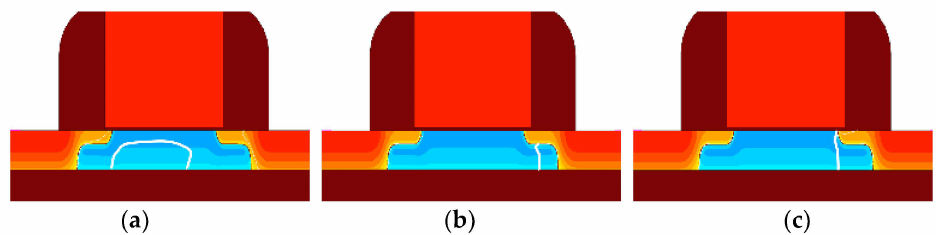
Figure 4. Length change of the depletion region (white curve) of the PN junction between the body and the drain at off state ( a ) before ion strike, ( b ) 8 ps after ion strike, and ( c ) 20 ps after ion strike.